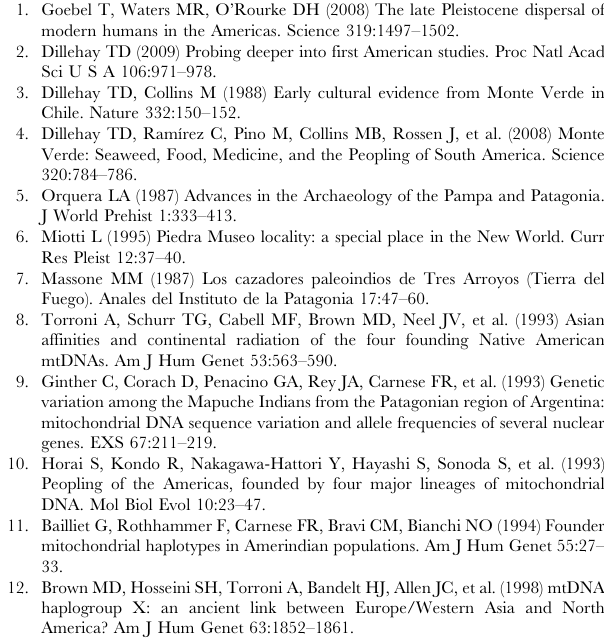
Table S2 Molecular basic indices for haplogroup/haplotype lineage. Table S3 Comparison of ages of TMRCA (years BP) calculated with different mutation rates. Table S4 Fst values between populations. Table S5 Sequences of the D-loop region of analyzed popula- tions. Table S6 Genbank and ID samples for D4h3a and D1 tree. (DOC) Supplemental Discussion S1 Discussion about mutational rate used. Supplemental Networks S1 Network made by hand